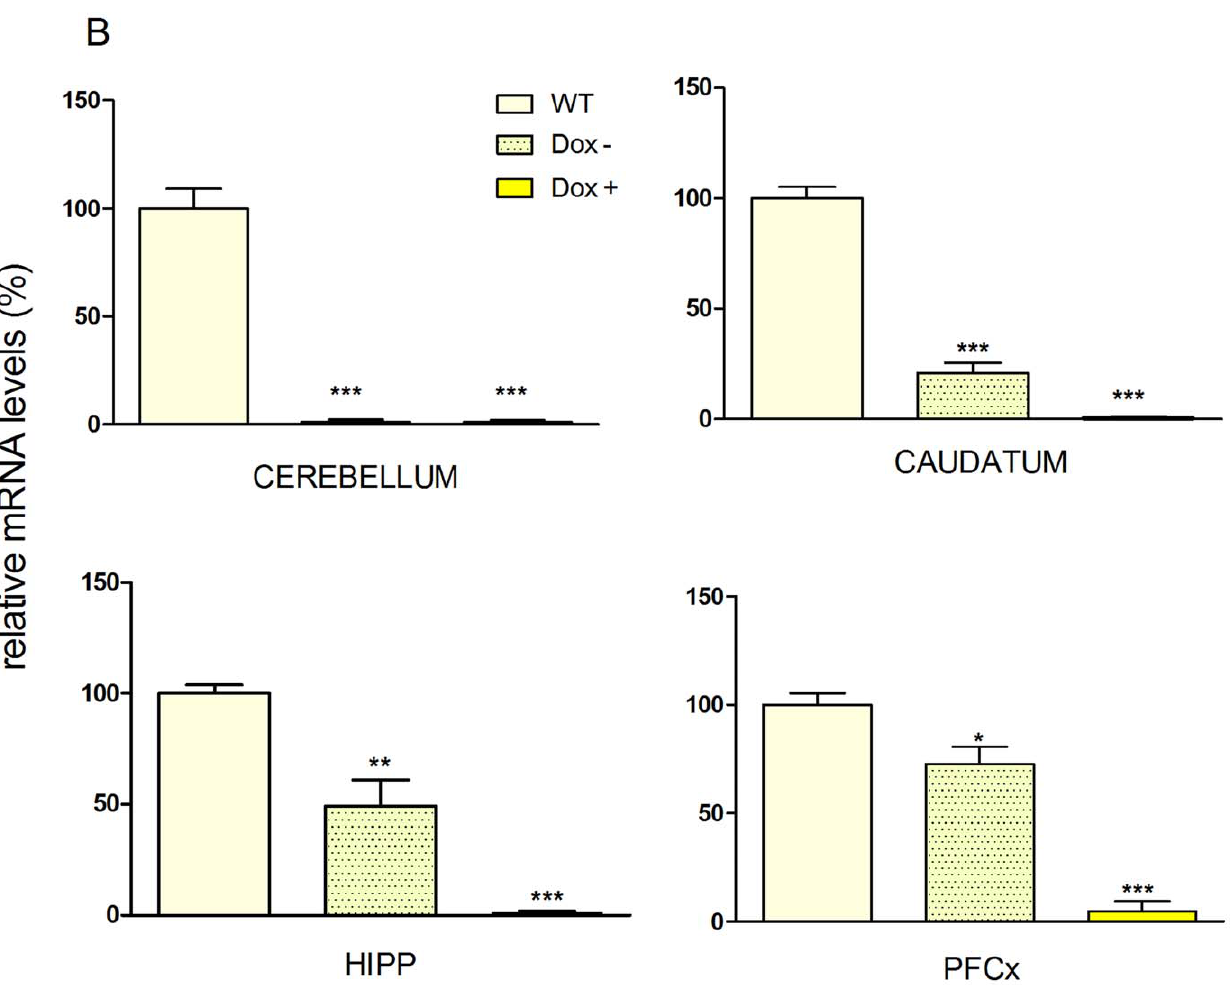
Figure 3. Real time-PCR CB1 mRNA expression in both WT and IR-hCB1 -/- mice either Dox treated or untreated. The mRNA expression detected by real time-PCR was measured in different brain areas from WT, untreated and Dox-treated IR-hCB1 -/- mice (n=3 for each group). *P , 0.001.